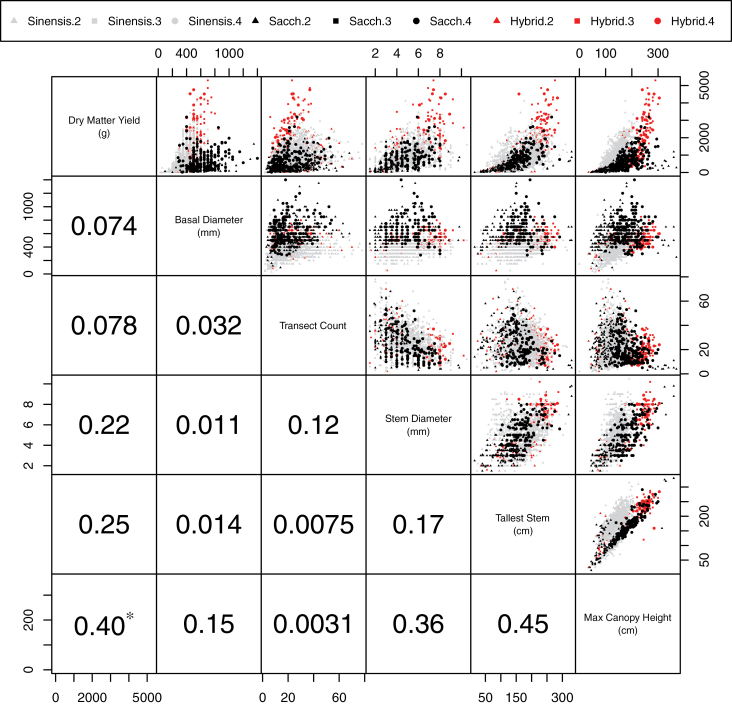
Pairwise trait plots for all replicates and associated r
2 values between traits for Y4 and Y5 by species: M. sinensis (grey), M. sacchariflorus (black), and hybrid (red); and by ploidy: diploid (triangle), triploid (square), and tetraploid (circle). The asterisk indicates the highest trait association with yield.